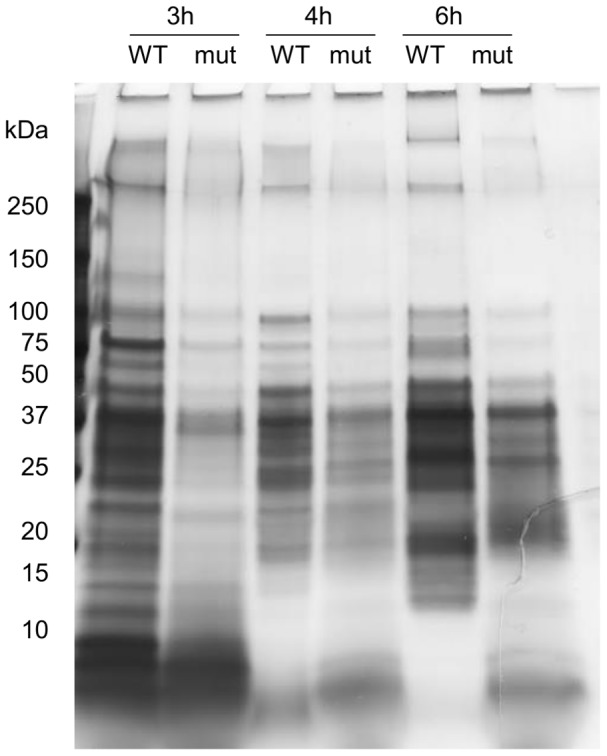
Decreased protein secretion in the ΔsecDF mutant.The ΔsecDF mutant secretes less protein than the B. cereus ATCC 14579 wild type strain. Equal volumes of normalized and 40-fold concentrated supernatants collected after 3 h (exponential phase), 4 h (transition phase) and 6 h (stationary phase) of growth were applied on 4–20% gradient SDS-PAGE gels and silver stained. The gel represents results of two independent experiments.